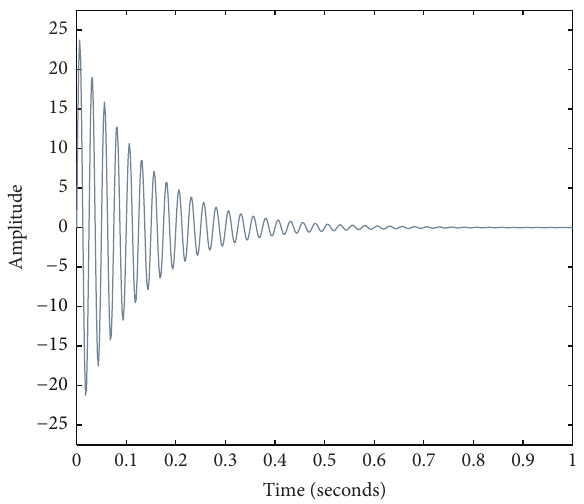
Figure 4: Microseismic event simulated using the formula of the dumped sine wave given in (16) with parameters 𝐴 = 20 , 𝜆 = 4 , 𝜔 = 80𝜋 , and 𝜃 = 0 , where the dominant frequency is 40 Hz and the sample rate is 2